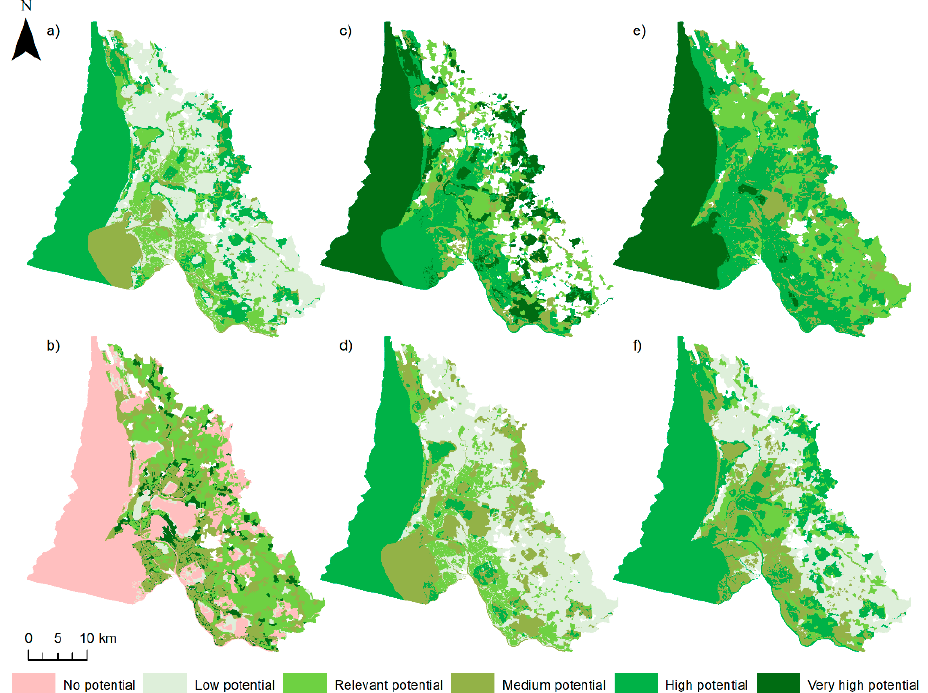
Figure 2. Maps of 6 ecosystem services in 3 ES categories. Provisioning: ( a ) wild animals used for nutritional purposes (CICES 1.1.6.1); ( b ) animals reared for nutritional purposes (CICES 1.1.3.1); in regulation and maintenance category: ( c ) maintaining nursery populations and habitats (CICES 2.2.2.3); ( d ) hydrological cycle and water flow regulation (including flood control and coastal protection, CICES 2.2.1.3); in cultural: ( e ) characteristics of living systems that enable scientific investigation or the creation of traditional ecological knowledge (CICES 3.1.2.1); ( f ) characteristics of living